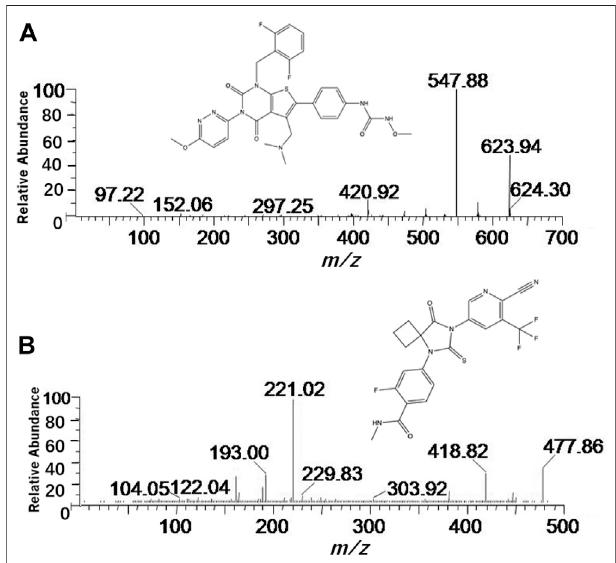
FIGURE 1 | Mass spectra of relugolix (A) and apalutamide (B) in the present research.